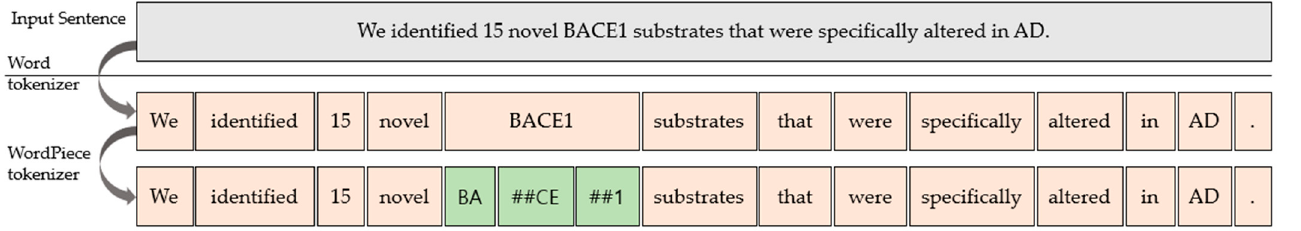
Figure 6. Word tokenizer and word-piece tokenizer.